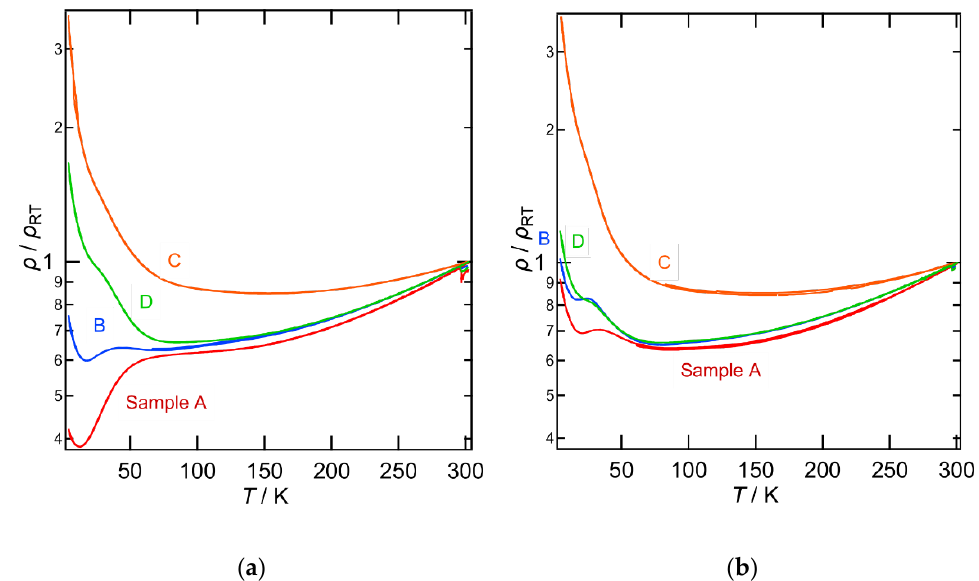
Figure 4. Temperature dependences of electrical resistivity of four crystals of 3 , where ( a ) is the first and ( b ) is the second run.